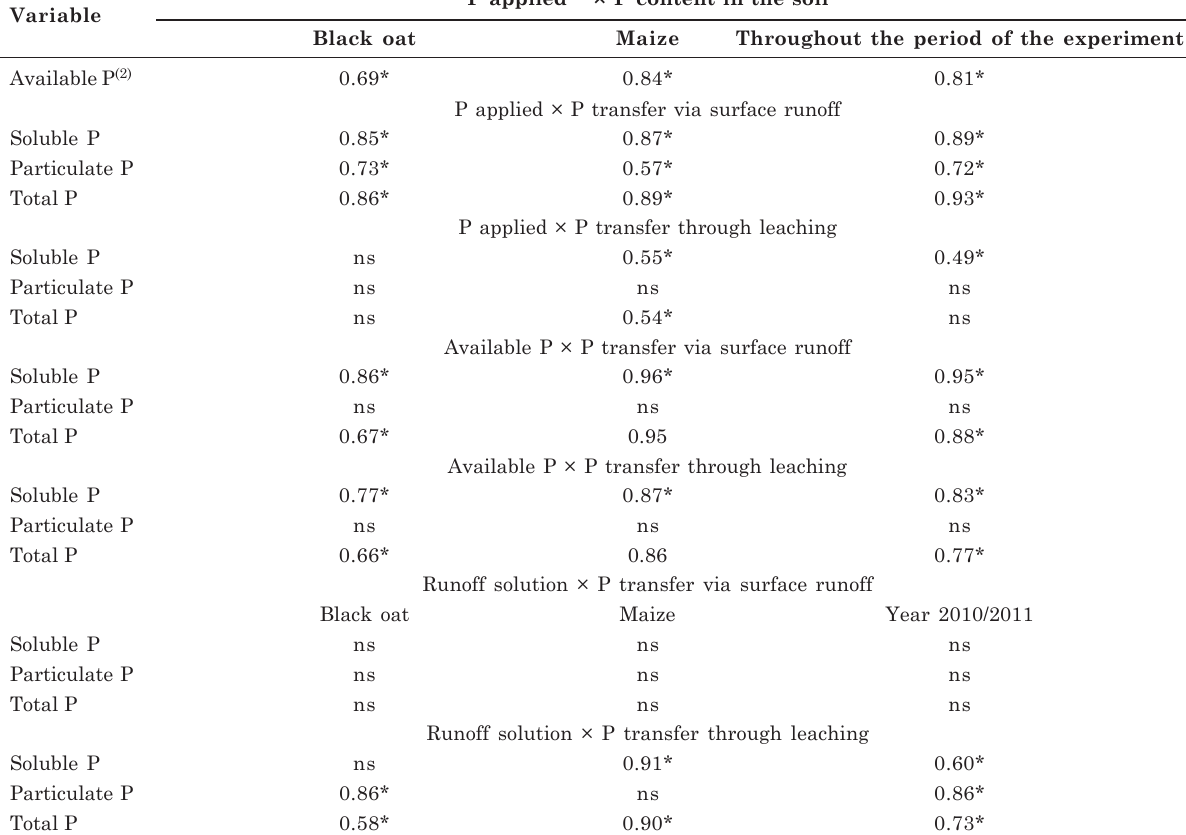
Table 4. Pearson’s correlation coefficient (r) involving the P quantities applied, available P contents in the soil, transfer of solution, soluble P, particulate P and total P in surface runoff and leaching in a Typic Hapludalf treated with nutrient